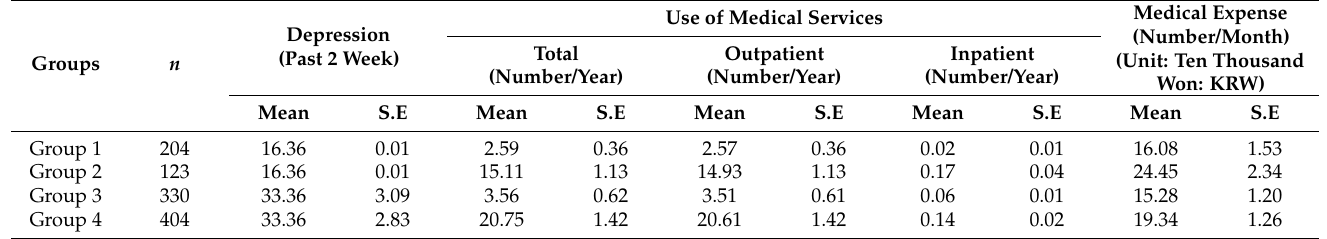
Table 4. Degree of subject’s depression. chronic disease, medical service use and medical cost.